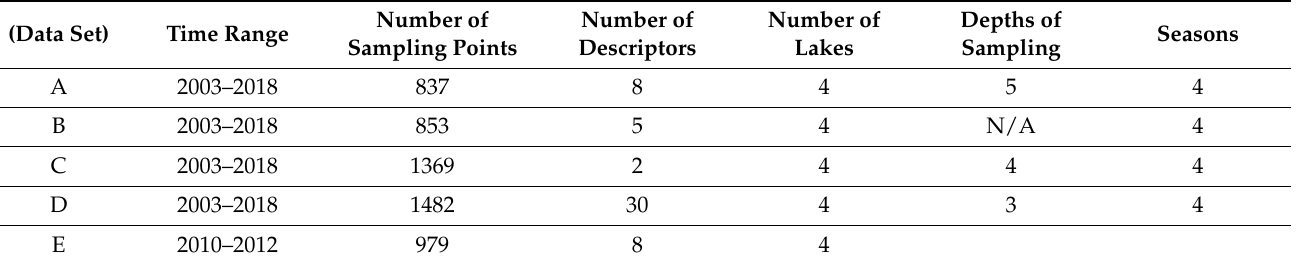
Table 1. A summary of data available for analysis (biological, physicochemical, and